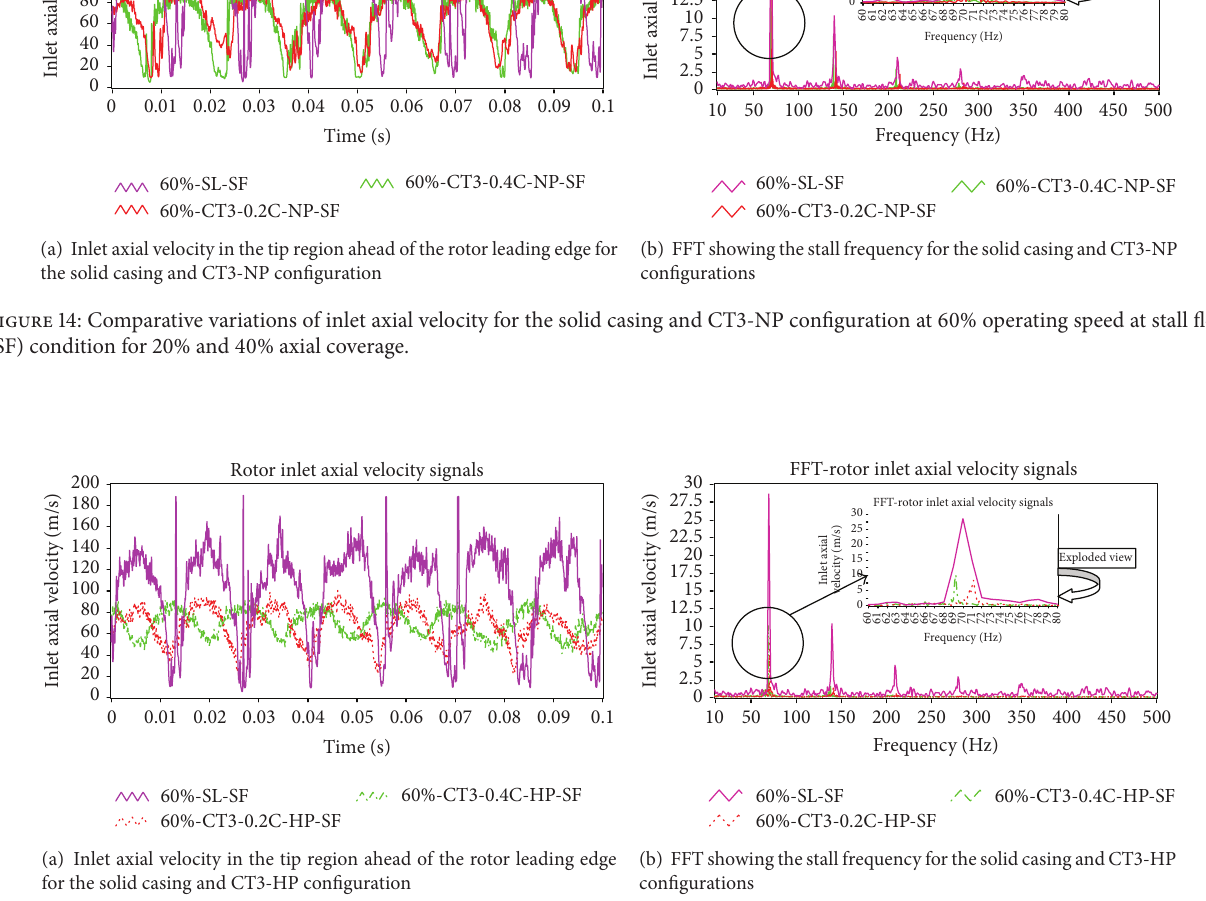
Figure 15: Comparative variations of inlet axial velocity for the solid casing and CT3-HP configuration at 60% operating speed at stall flow (SF) condition for 20% and 40% axial